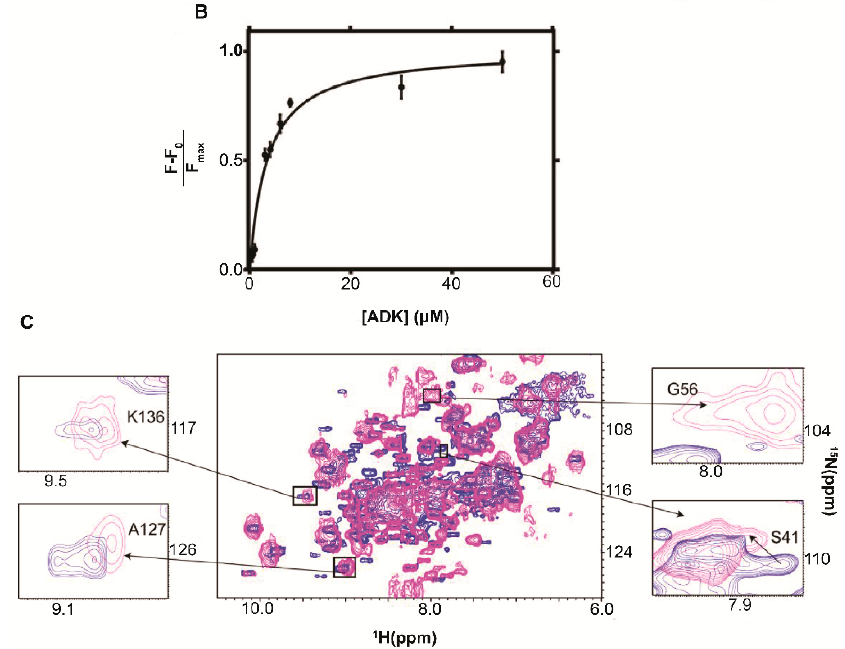
Figure 5. Quinary interactions of ADK in E. coli . ( A ) (Center) Overlay of in vitro 1 H- 15 N CRINEPT-HMQC-TROSY spectra of 10 µ M [ U - 2 H, 15 N] ADK without (black) and with 2.5 µ M ribosome (red). Surrounding panels show overlays of individual residues including in-cell NMR peaks (blue). ( B ) Fluorescence titration of 0.5 µ M ribosome with ADK. Tryptophan fluorescence was measured at an emission wavelength of 350 nm by using an excitation wavelength of 280 nm. Curve fitting to a single site-binding isotherm yielded a K d of 3.7 ± 0.4 µ M. F o is the fluorescence in the absence of ADK, and F max is the maximum fluorescence of the ADK − ribosome complex. Fluorescence titration experiments were performed in triplicate. ( C ) Overlay of the in-cell 1 H- 15 N CRINEPT-HMQC-TROSY spectra of [ U - 2 H, 15 N] ADK in the absence (blue) and presence (magenta) of 100 µ g/mL chloramphenicol. K136 and A127 (left insets) in chloramphenicol treated cells exhibit chemical shift changes consistent with ATP bound ADK; G56 and S41 peaks (right insets) exhibit chemical shift changes consistent with AMP bound ADK. Panels A and B are adapted from DeMott et al. (2017) [26] . Panel ( C ) is adapted from Majumder et al. (2015) [14] .